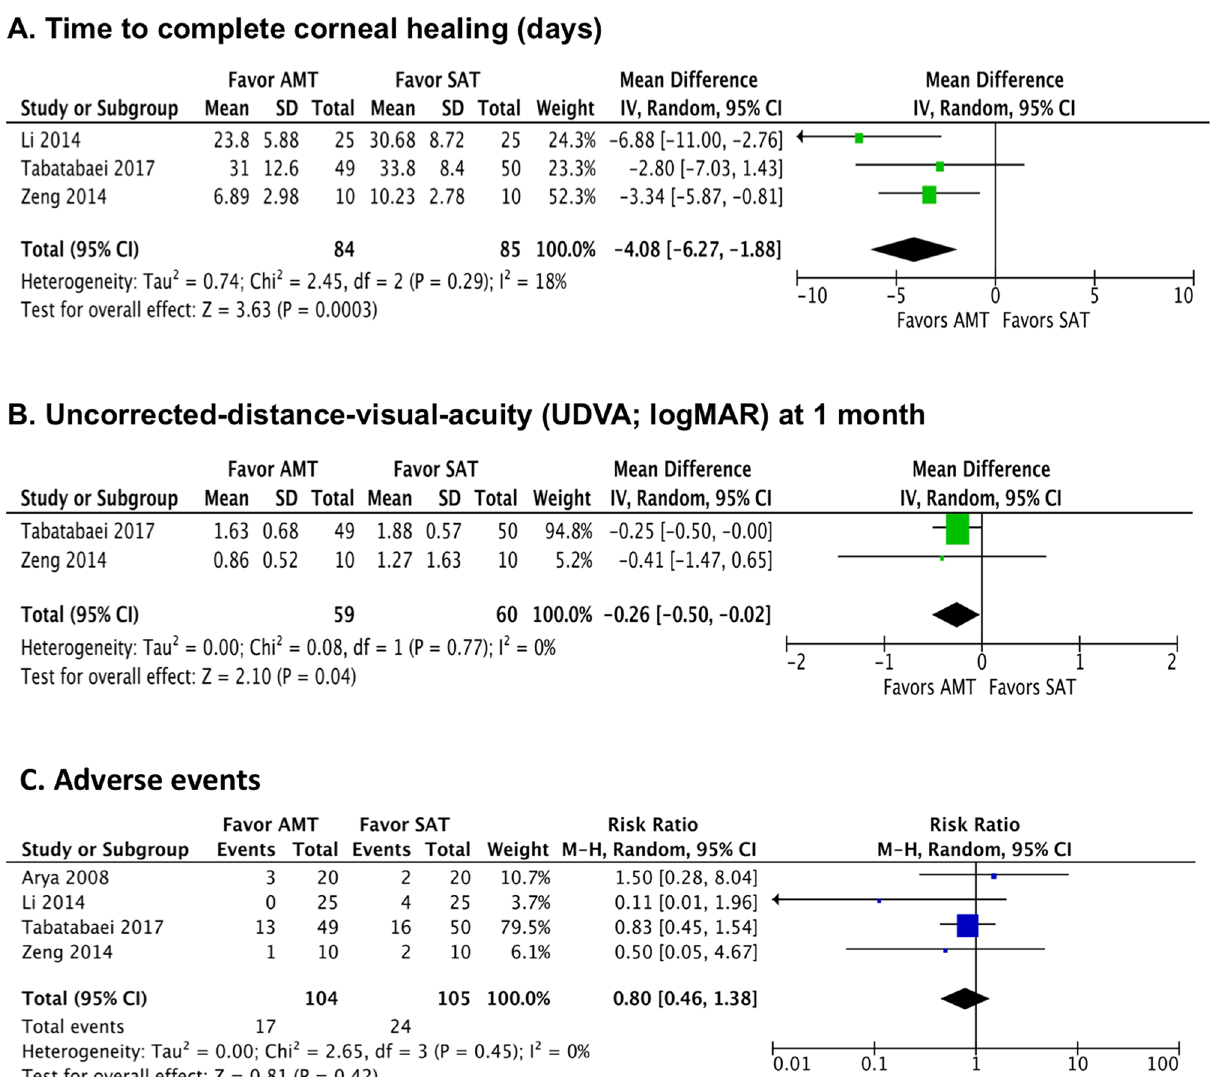
Figure 3. Summary of the meta-analysis (forest plot) comparing the efficacy between adjuvant amniotic membrane transplantation (AMT) plus standard antimicrobial treatment (SAT) and SAT alone in eligible randomised controlled trials, in terms of: ( A ) time to complete corneal healing; ( B ) uncorrected-distance-visual- acuity; and ( C ) risk of adverse corneal healing, reducing corneal vascularization and potentially achieving better visual outcome. However, two RCTs have some concerns on the risk of bias and another two RCTs have high risk of bias. Due to the lack of information in the randomization process, lack of blinding, and under-powered sample size. In addition, none of the RCTs were prospectively registered with any clinical trial database, which limits the assessment of selective reporting of the outcomes. Of all four RCTs, only Tabatabaei et al. 25 conducted a sample size calculation based on the anticipated differ- ence in the size of corneal scar (mean effect size of 4 mm 2 , standard deviation of 6 mm 2 , and power of 90%), which yielded a sample size of 48 eyes in each group. However, it is noteworthy to mention that size of corneal scar is not a routine outcome measure for IK. Based on the findings of our systematic review, an appropriate sample size (using time to complete corneal healing as the main outcome measure) is estimated to be at approximately 200 participants/eyes (based on a mean difference or effect size of 4.08 days, standard deviation of 14.56 days, power of 80% and alpha of 5%). This sample size is also supported by some previous RCTs examining the effectiveness of therapeutic CXL (or PACK-CXL) for IK, where an appropriate sample size was estimated at around 200–250 participants, using time to complete corneal healing as the main outcome measure 10,77 . This large sample size would then potentially control for various potential confounding variables that could affect the time to complete healing, including the demographic factors, initial size and severity of the corneal ulcer, types of organisms, and underlying comorbidity (e.g. diabetes).